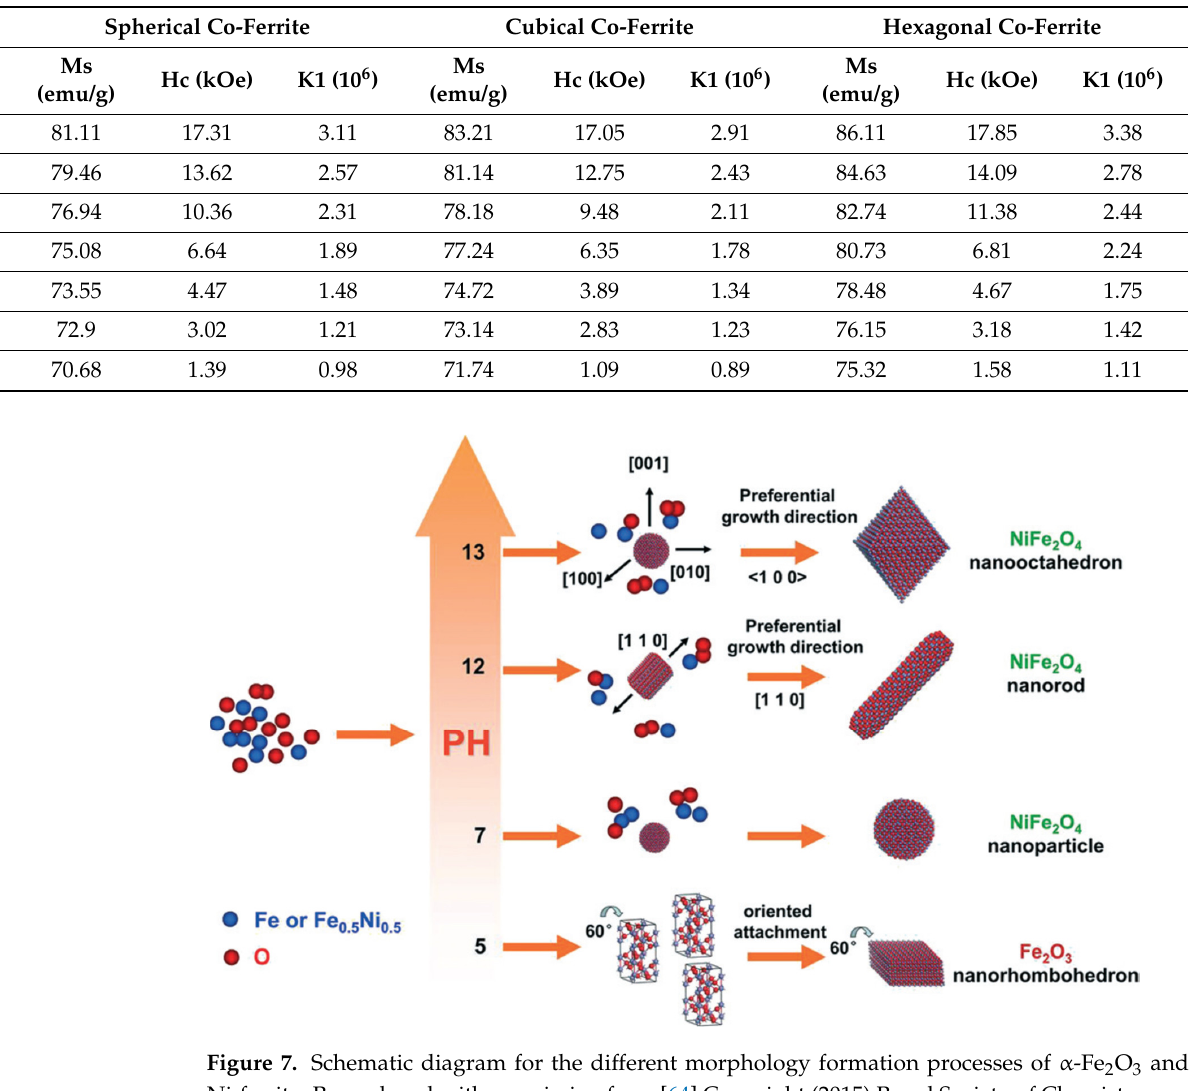
Table 1. Saturation magnetization, coercivity and K1 values of spherical, cubical and hexagonal shaped Co-ferrites [63].